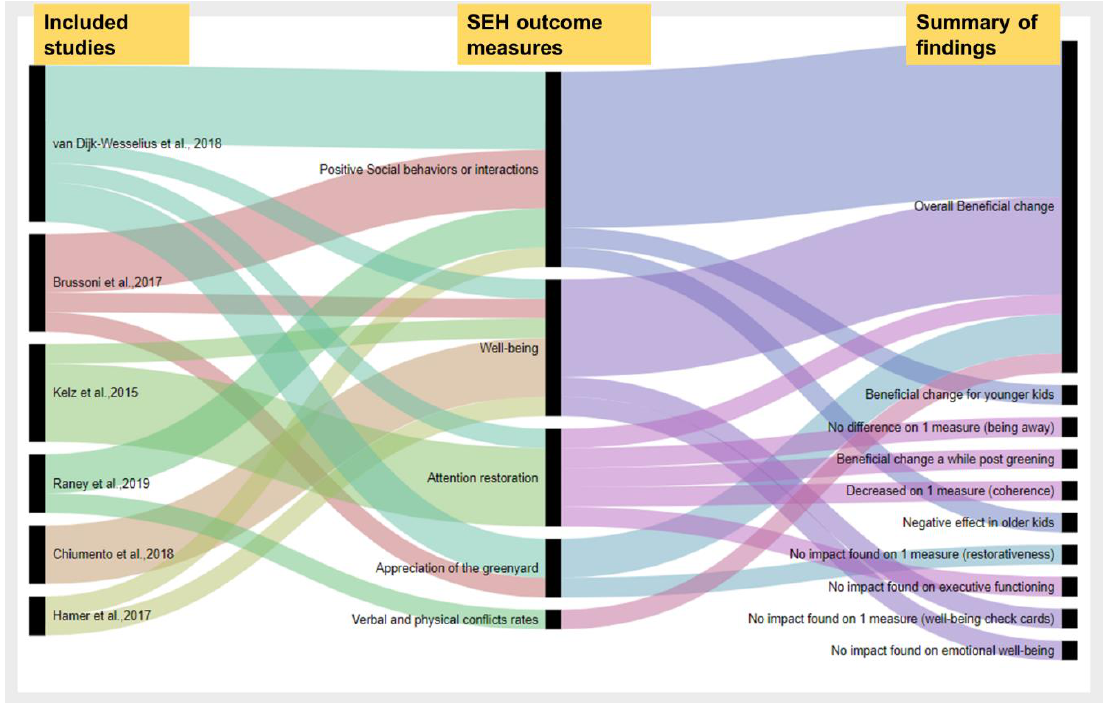
Figure 3. The impact of schoolyard greening on socioemotional health outcomes: The first column represents the authors, the second column represents the SEH outcome measures, while the third column represents the summary of findings for each outcome. This graphical representation shows an overall trend in findings across studies.